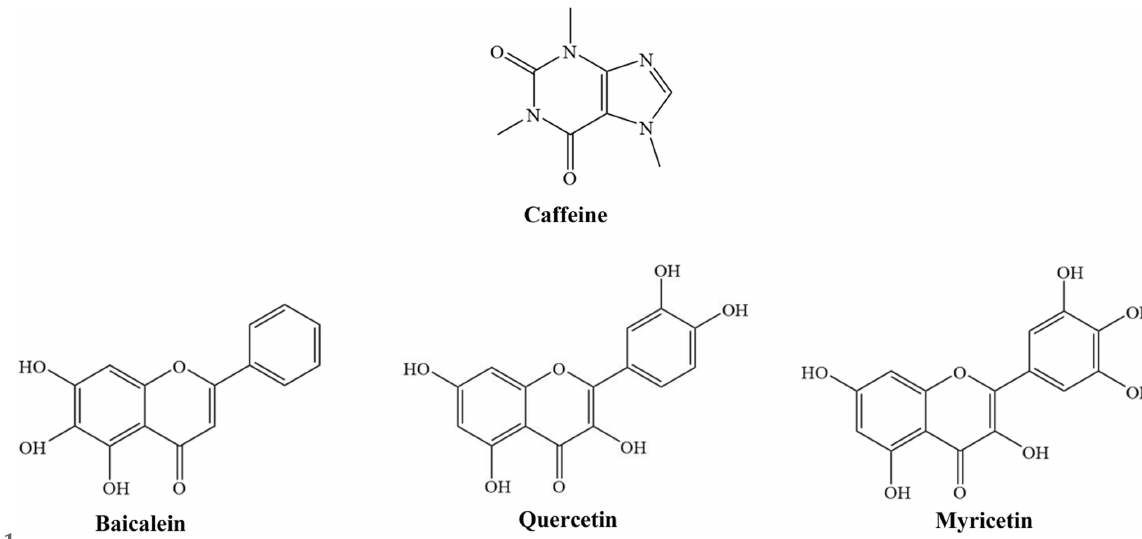
Figure 1 Molecular structures of caffeine and the three